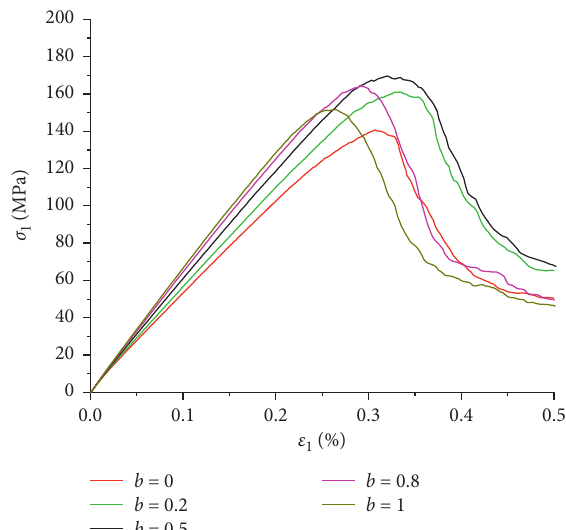
Figure 4: Stress-strain curves with different intermediate stress